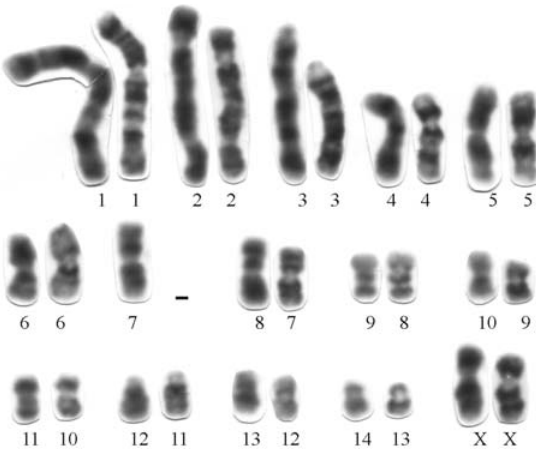
Figure 10 - Comparison between 2n=30 (left) and 2n=28 (right) karyomorphs from Usina Hidrelétrica Samuel (RO).